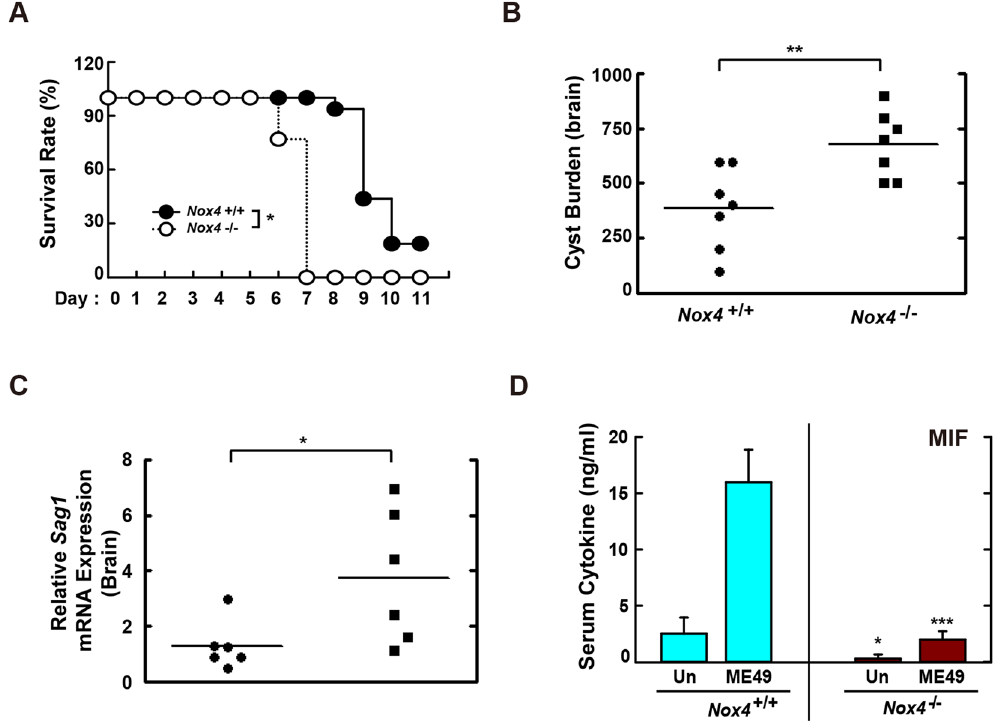
Figure 7. Nox4 is required for the host resistance against both RH and ME49 strain of T . gondii . ( A ) Survival of Nox4 + / + and Nox4 − / − mice (n = 13 per genotype) infected with 200 tachyzoites of T . gondii RH strain (i.p. injection). ( B – D ) Nox4 + / + and Nox4 − / − mice (n = 5 per genotype) were infected with 40 cysts of T . gondii ME49 strain (i.p. injection) for 20 days. ( B ) Number of cysts in brain of Nox4 + / + and Nox4 − / − mice were counted using a microscope. ( C ) The mRNA expression for T . gondii -specific gene Sag1 in brain of Nox4 + / + and Nox4 − / − mice was evaluated by qPCR analysis. ( D ) Serum MIF levels from Nox4 + / + and Nox4 − / − mice were assessed by ELISA analysis. * P < 0.05, ** P < 0.01, *** P < 0.001, compared with Nox4 + / + mice infected with T . gondii (log-rank test (for A) or two-tailed Student’s t-test (for B – D